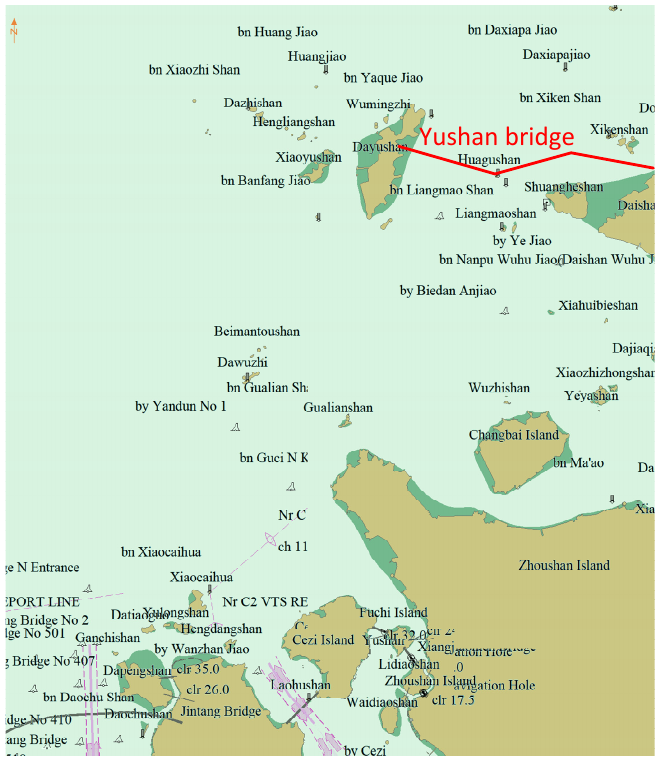
Figure 7. Experimental area and location of Yushan bridge. Yushan bridge is a newly constructed facility. During the construction of Yushan bridge, ships are banned from passing through the bridge.